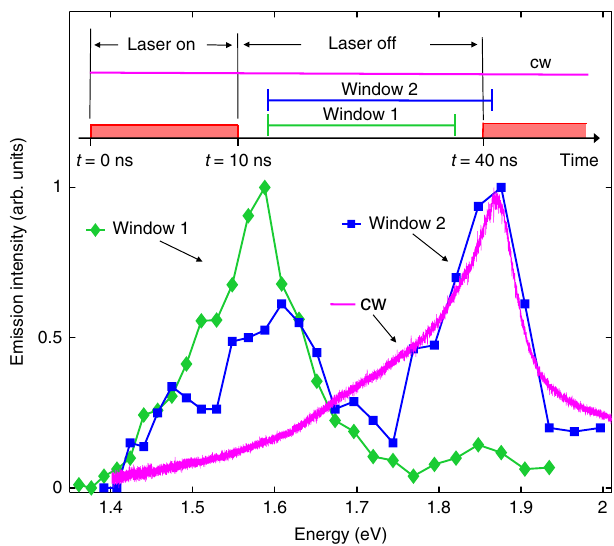
Fig. 2 Emission spectra. Spectrum taken in a time-integration window after the laser pulse (window 1) when most of short-lifetime DXs recombine (green diamonds). The spectrum shows emission of long-lifetime IXs. The laser pro fi le and signal integration windows are shown above. The laser has a pulse duration of 10 ns and a period of 40 ns. Window 2 presents emission from a combination of the laser off and the laser on in a ratio that shows both IX and DX (blue squares). cw spectrum (magenta line) is dominated by direct recombination. T = 300 K. V g = 0